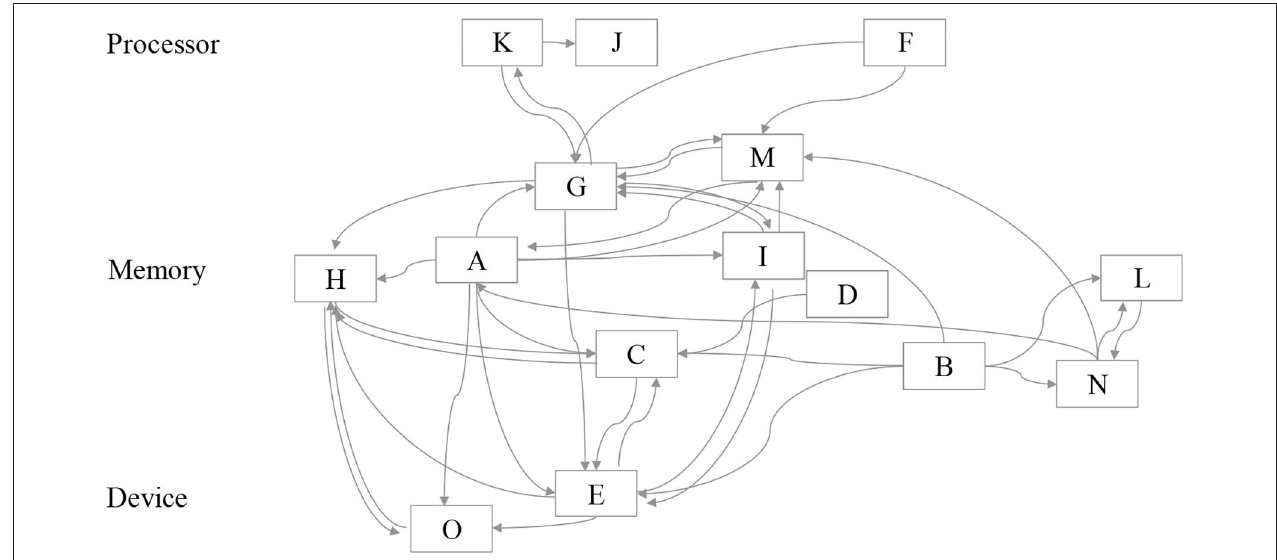
FIGURE 5 | Co-inventor network of star researchers. Each star researcher is placed in the technology layer more closely related to their